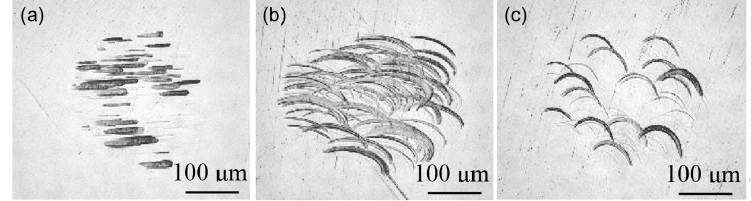
Figure 4. Observation of vibration traces under ( a ) lateral, ( b ) circular and ( c ) elliptical vibrating motions.